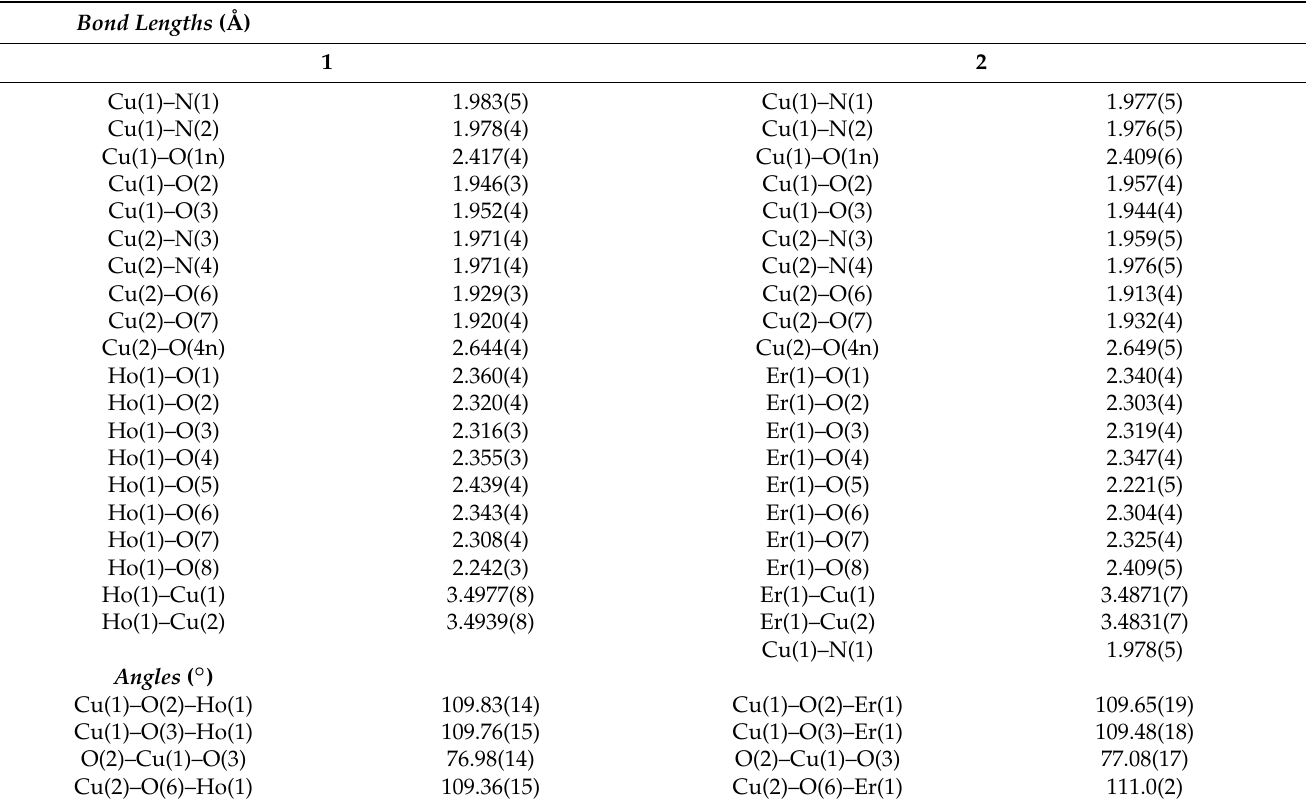
Figure 4. The molecular structure of 1 . Displacement ellipsoids are drawn at the 30% probability level. Table 3. Selected interatomic distances and bond angles for 1 and 2